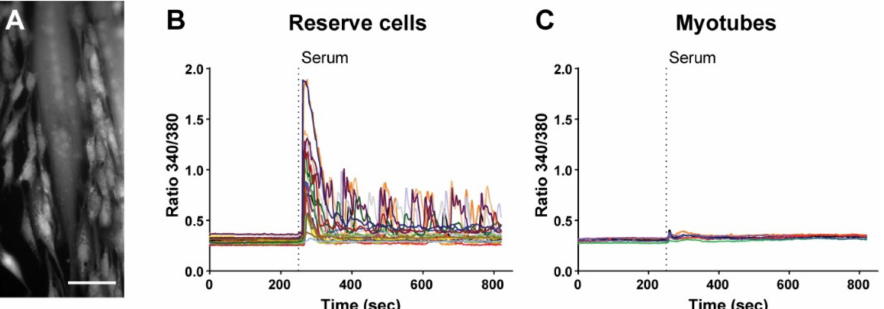
Figure 1. Serum induces Ca 2+ responses in reserve cells but not in myotubes. ( A ) Representative image of Fura-2-loaded cells 48 h after differentiation. The multinucleated myotubes and the mononu- cleated RC can be easily recognized. Scale bar: 100 µ m. ( B , C ) Cytosolic Ca 2+ recordings showing the serum-induced cytosolic Ca 2+ response in RC ( B ) but not in myotubes ( C ). Each panel ( B , C ) is the response of a representative coverslip of n = 21 reserve cells and n = 6 myotubes acquired in three independent